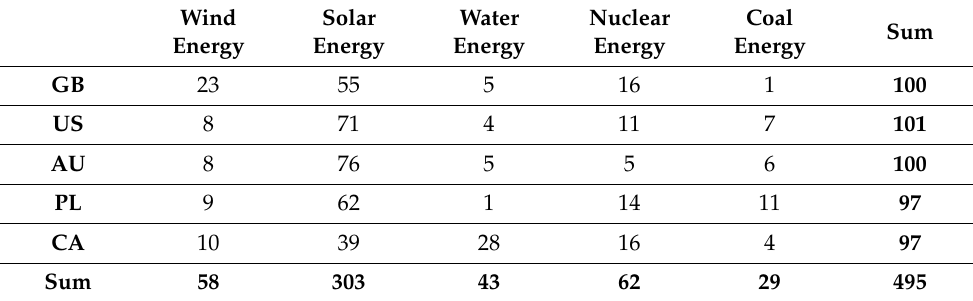
Table 4. Electric energy preferences when given only one choice, N by country.